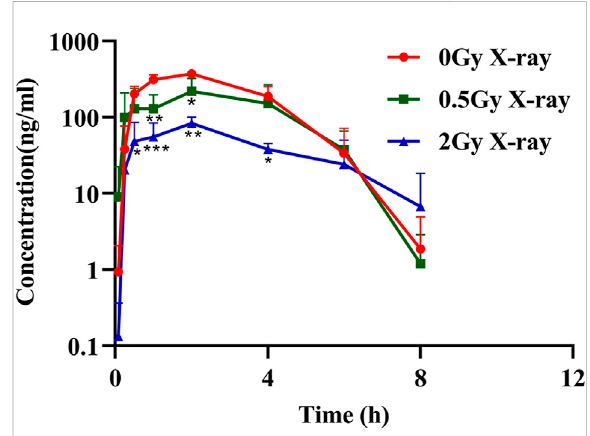
FIGURE 2 The mean plasma concentration – time pro fi le of apatinib in rat plasma presence or absence abdominal X-ray irradiation after intragastrical administration of 45 mg/kg (Mean ± SD, n = 3). * signi fi cantly different from the absence X-ray irradiation group at p < 0.05, ** signi fi cantly different from the absence X-ray irradiation group at p < 0.01, *** signi fi cantly different from the absence X-ray irradiation group at p < 0.001.